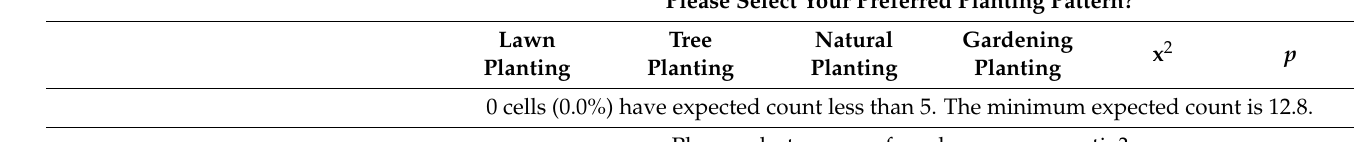
Gardening Planting